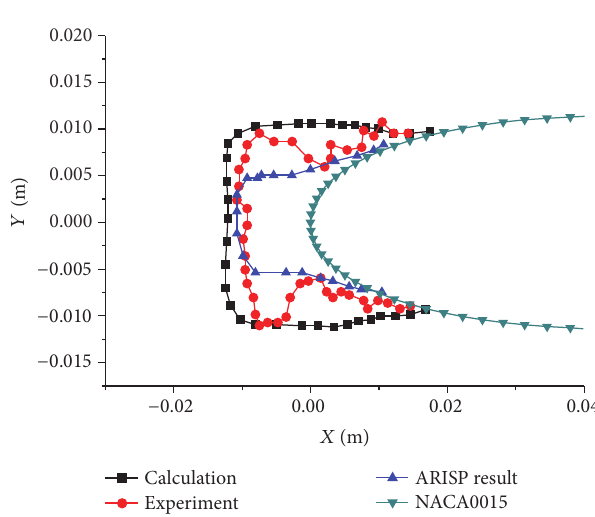
Figure 4: Comparison of rotor blade ice shape in condition